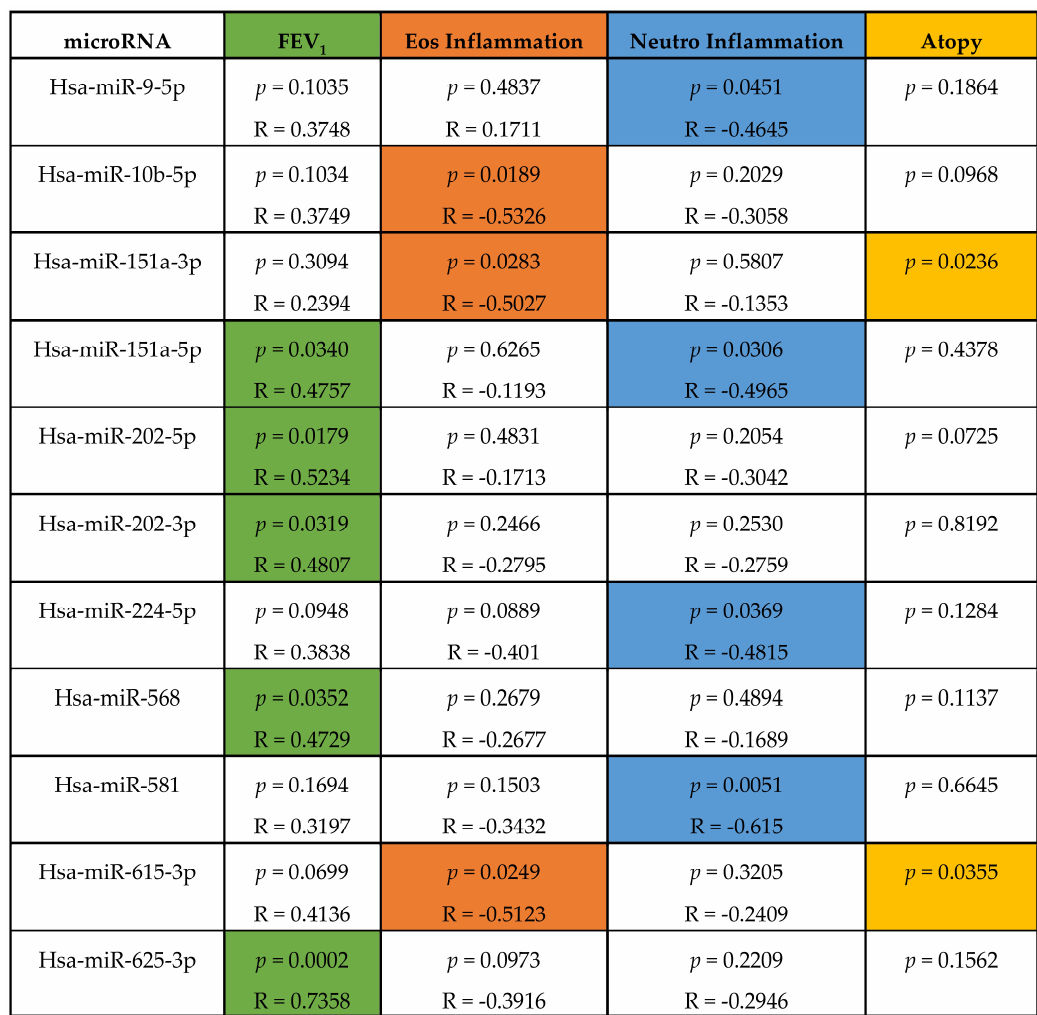
Figure 3. MicroRNAs downregulated in severe asthma correlate to FEV 1 and immune inflammation. MicroRNAs with SA/HC ratio < 0.33 ( p ≤ 0.01, FDR ≤ 0.15) in nanovesicles from SA were correlated (Spearman’s rank) with FEV 1 (green), eosinophilic inflammation (orange), or neutrophilic inflammation (blue) . Influence of atopy (yellow) on microRNAs significantly correlated to FEV 1 , eosinophilic inflammation, or neutrophilic inflammation, which were calculated using the Mann-Whitney test ( p ≤ 0.05).